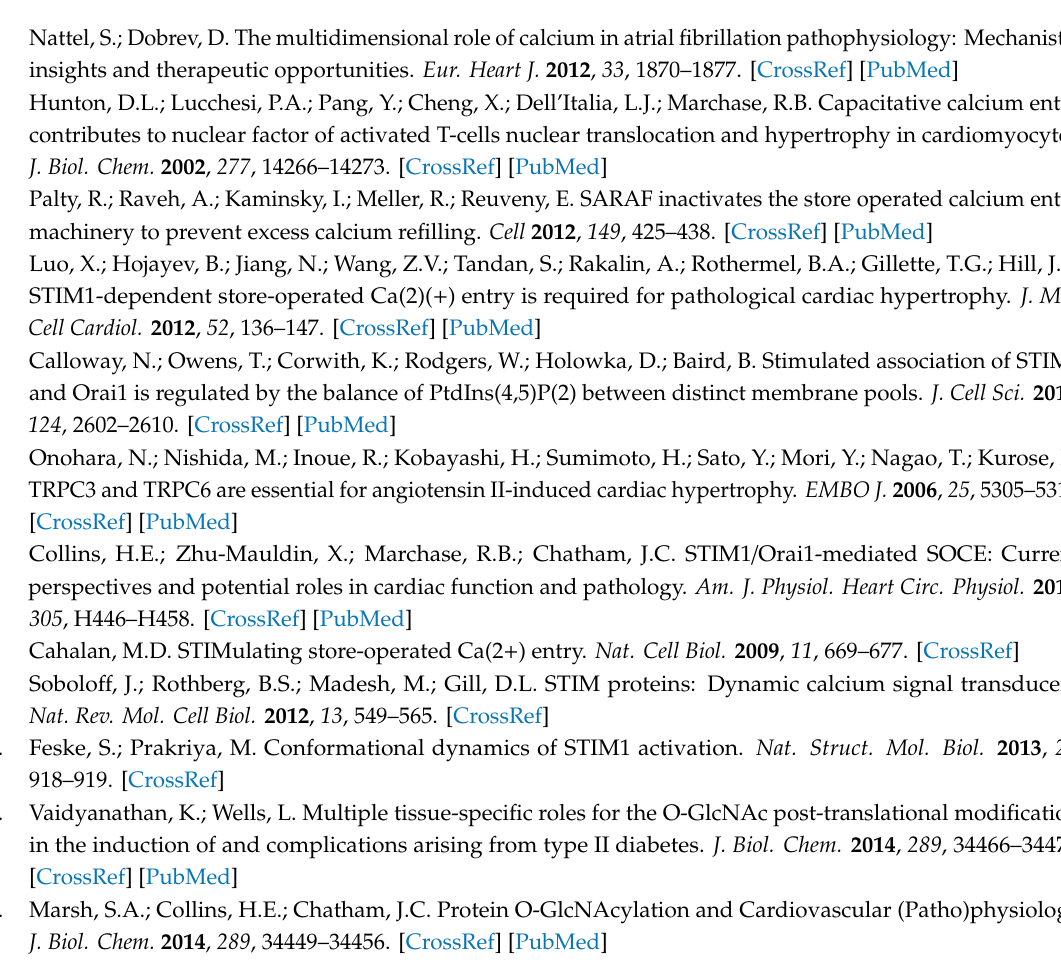
Table S1: The body and heart weights, echocardiographic measurements and biochemistry data in Normal-VLDL and MetS-VLDL injected